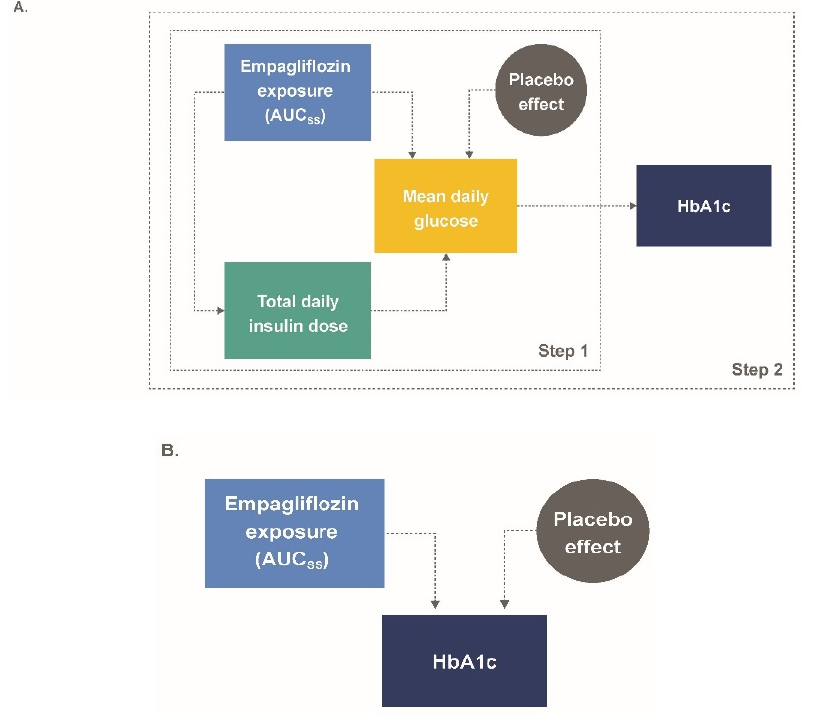
Figure 1. ( A ) M-EASE-1 and ( B ) M-EASE-2 schematic final model structure. AUC ss , area under the curve at steady-state; HbA1c, glycated hemoglobin; MDG, mean daily glucose; TDID, total daily insulin dose. Table 2. Summary of simulation scenarios for model evaluation and simulation of M-EASE-1 and